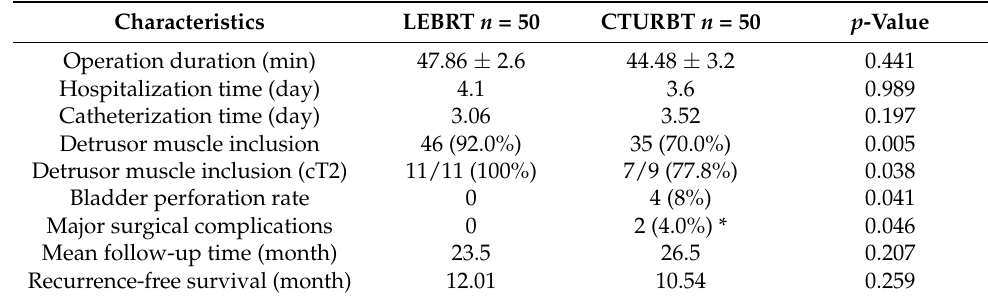
Table 2. Intra- or postoperative characteristics between LEBRT and CTURBT.